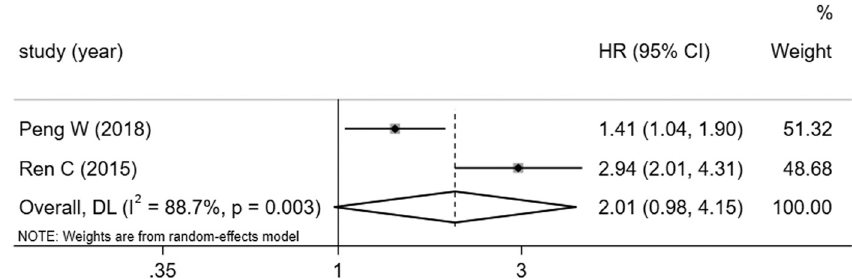
Figure 6: Forest plots of the studies that evaluated the HRs of high miR - 155 expression on